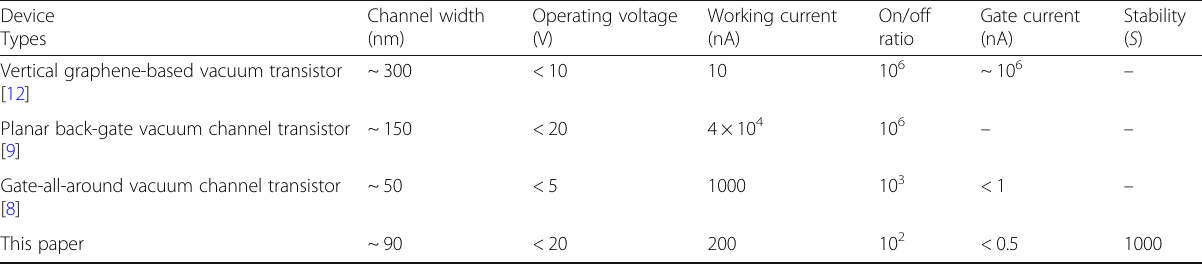
Table 1 Comparison of the performances of nanoscale vacuum channel transistors Device